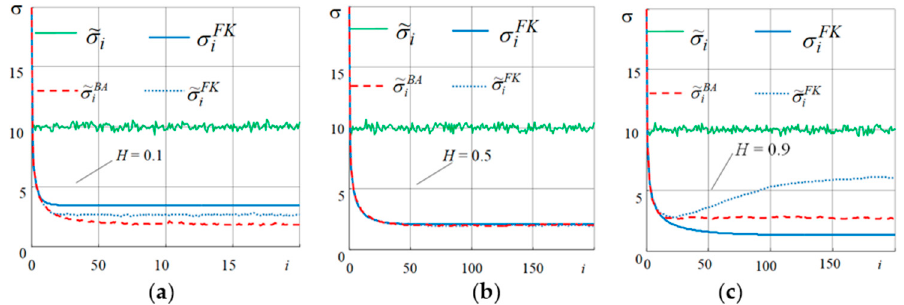
Figure 4. R.m.s. of estimation errors with different Hurst parameters ( H .). ( a ) H = 0.1, ( b ) H = 0.5, ( c ) H = 0.9. As Figure 4a–c show σ FK